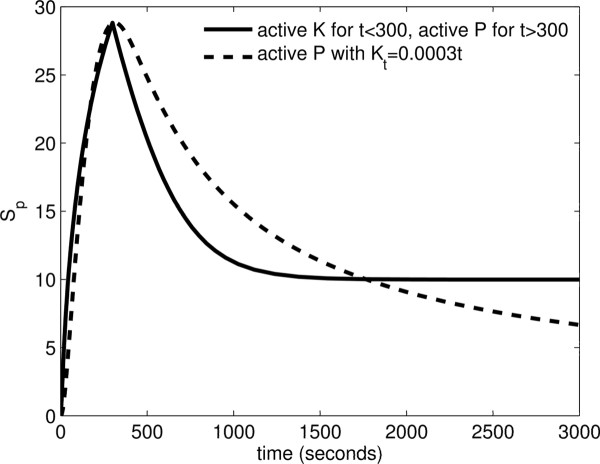
Transient phosphorylation of phosphoinositides due to enzymatic complex formation. Comparison of the two scenarios; solid line represent the case when a signalling trigger is simulated. Parameters used are the following: λ−1 = 10 s−1,λ1 = 1μM−1s−1,k1 = 1 s−1,λ−2 = 10 s−1,λ2 = 1μM−1s−1,k2 = 1 s−1,κ−1=50s−1,κ1 = 1μM−1s−1,Kt = 0.1μM,Pt = 0.2μM,St = 300μM.The other parameters are λ−4 = 1 s−1,λ4 = 75μM−1s−1,k4 = 100 s−1for t≤300 s and λ−3 = 10 s−1,λ3 = 10μM−1s−1,k3 = 500 s−1, for t>300s. Dashed line represent the case when kinases are recruited linearly in time as Kt = 0.0003t. Other parameters used are the following: λ−1 = 10 s−1,λ1 = 1μM−1s−1,k1 = 1 s−1,λ−2 = 10 s−1,λ2 = 1μM−1s−1,k2 = 1 s−1,κ−1 = 50 s−1,κ1 = 1μM−1s−1,λ−3 = 10 s−1,λ3 = 10μM−1s−1,k3 = 500 s−1,Pt = 0.2μM,St = 300μM.